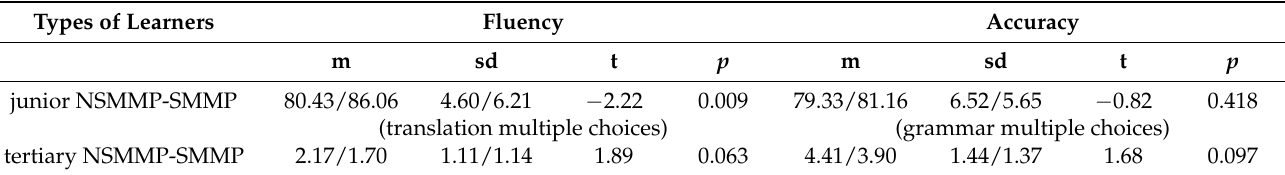
Table 3. Results of juniors’ oral test and tertiary learners’ multiple